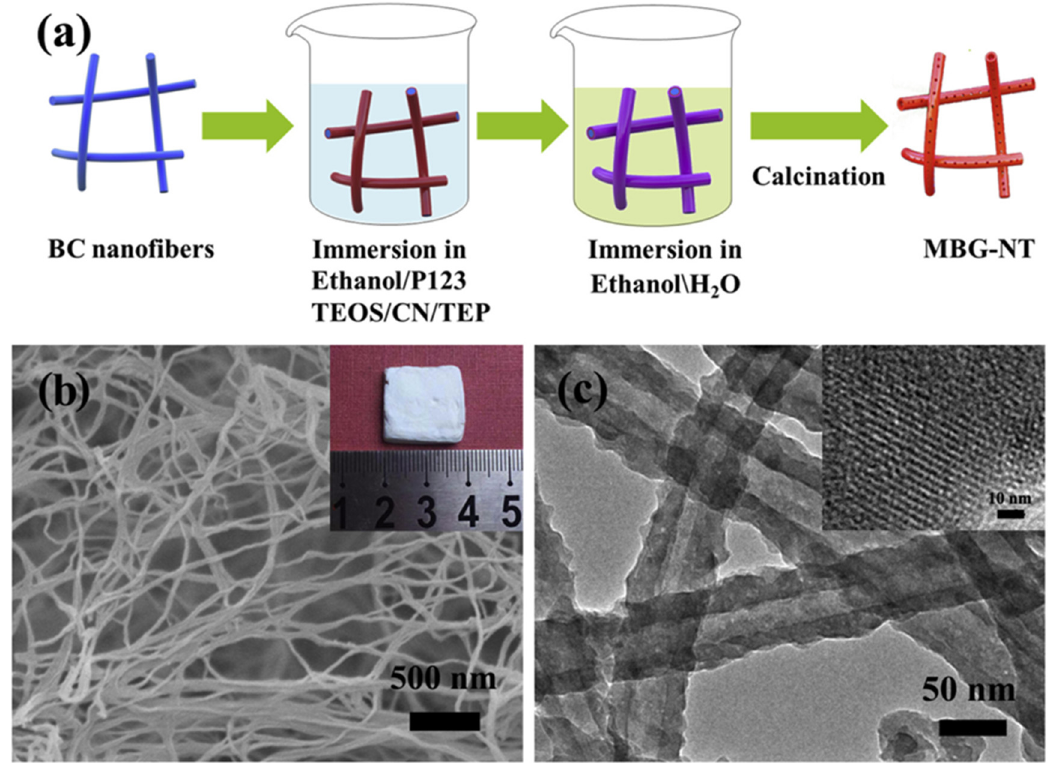
Figure 4. Schematic of the fabrication method of MBG-NT scaffold ( a ), SEM ( b ), and TEM ( c ) images of MBG-NT scaffold with a digital image (inset) and HRTEM image (inset), respectively. Reproduced with permission from [82]. Copyright 2019 Elsevier.